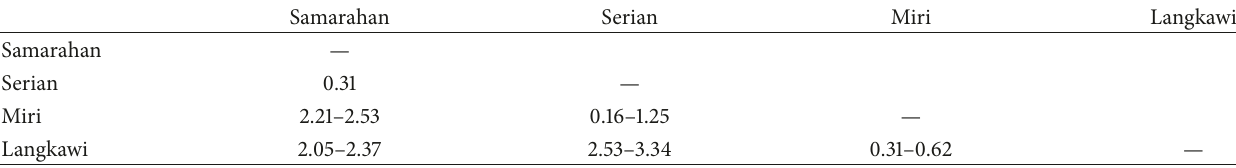
Table 2: Summary of genetic distance in percentage (%) for mtDNA Cyt b-CR gene sequences of T. schlegelii based on the locality in Malaysia.